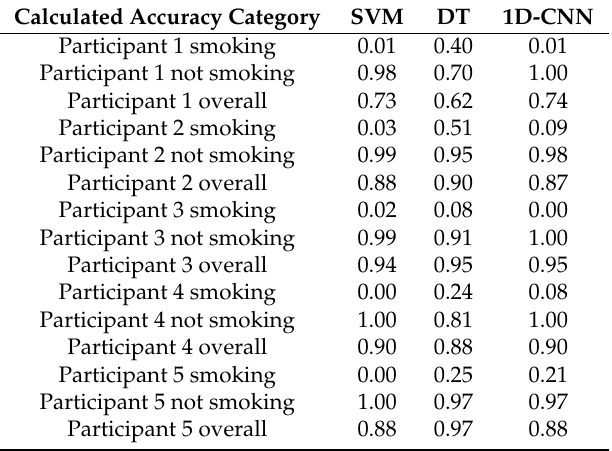
Table 2. The average accuracy based on only 3 GPS values.